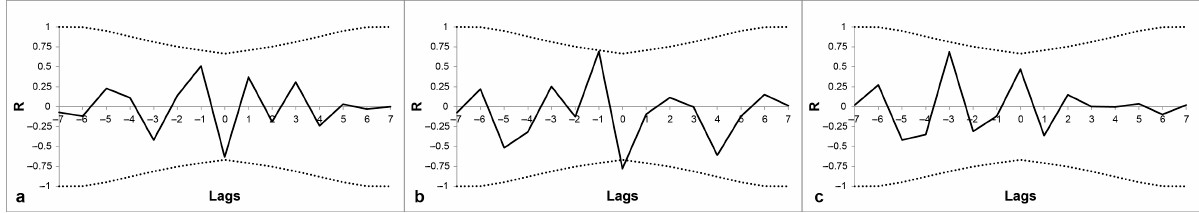
Figure 8. ( a ) The cross correlation of volumetric changes (m 3 m − 1 ) for the side profiles (northern and southern) on Mari Ermi beach; ( b ) Is Arutas beach; and ( c ) Maimoi beach.